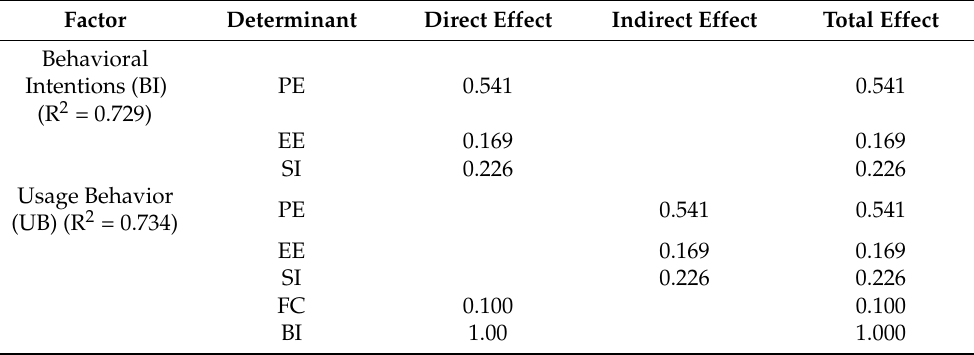
Table 8. Direct, indirect and total effects for each construct. Factor Determinant Direct Effect Indirect Effect Total